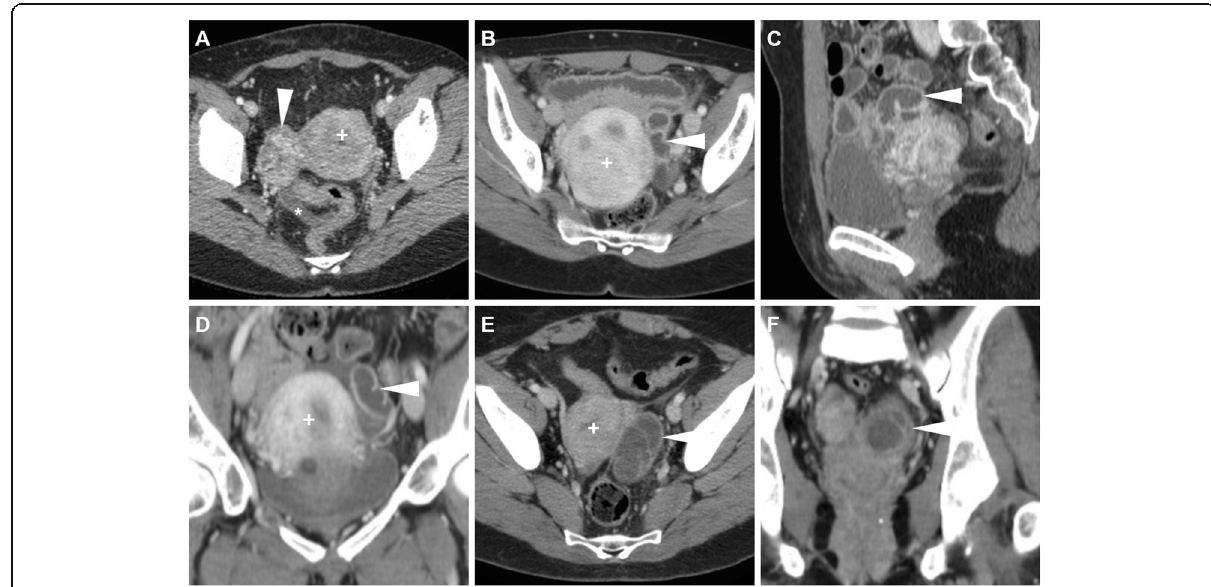
Fig. 13 CT appearances in three different patients with a clinical diagnosis of PID. a Heterogeneously enhancing, unilaterally enlarged right ovary (arrowhead). Note uterus (plus sign), mild cul-de-sac effusion (asterisk). b – d Multiplanar images of tubular-shaped left salpingitis (arrowheads), distended with prominent mural enhancement. e – f Enlarged, septated left ovary (arrowheads) with thickened walls consistent with early tubo-ovarian abscess (TOA)